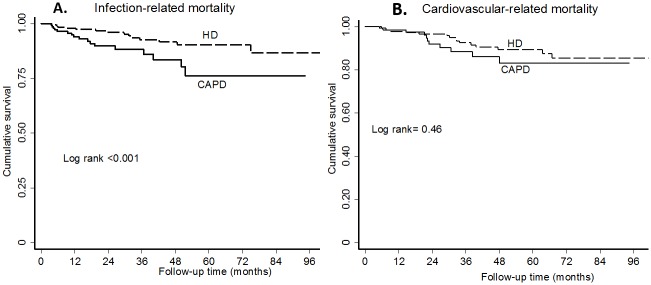
Kaplan-Meier survival curves cause-specific mortality according to dialysis modality.a. Infection-related mortality. b. Cardiovascular mortality.